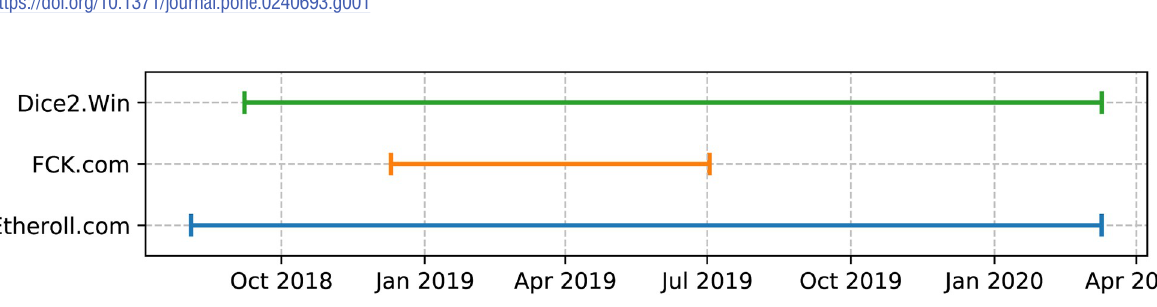
Fig 2. Transaction data gathering timelines for each of the three decentralised gambling applications studied.